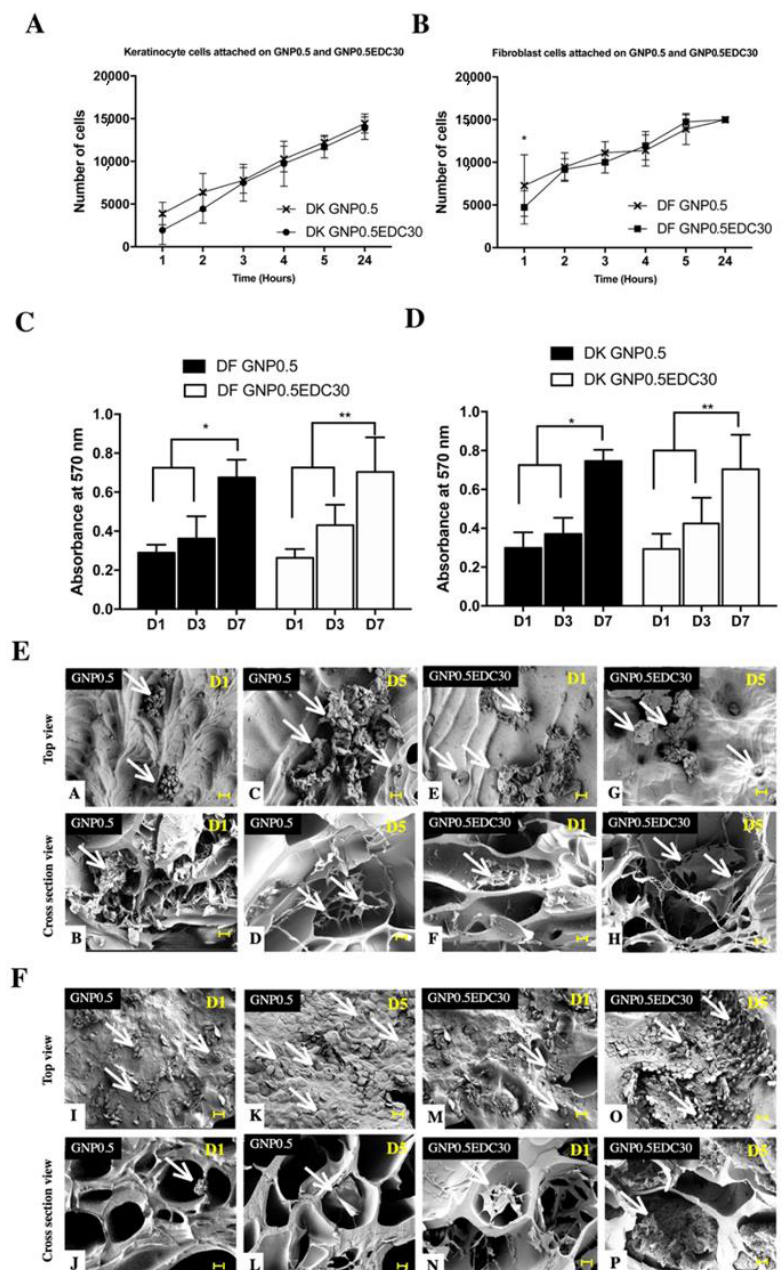
Figure 6. Cell attachment of ( A ) HEK and ( B ) HDF on GS crosslink with GNP0.5 / GNP0.5EDC30 at 24 h. Significant di ff erence at first hour of DF attachment are represented. Analysis of cell proliferation of ( C ) HEK and ( D ) HDF using MTT assay after 1, 3 and 7 days of cell seeding (n = 3). Cells seeded on both GNP0.5 / GNP0.5EDC30 sca ff olds proliferate e ffi ciently after day 3. * p ≤ 0.05; ** p ≤ 0.01. Electron micrograph of crosslinked sca ff old seeded with human dermal cell. ( E ) HDF cells and ( F ) HEK cells (I-P) seeded on GS crosslink with GNP0.5 / GNP0.5EDC30 at day 1 (D1) until day 5 (D5) (250X magnification) / scale bar 20 µ m are shown. White arrows indicate the cells attached.